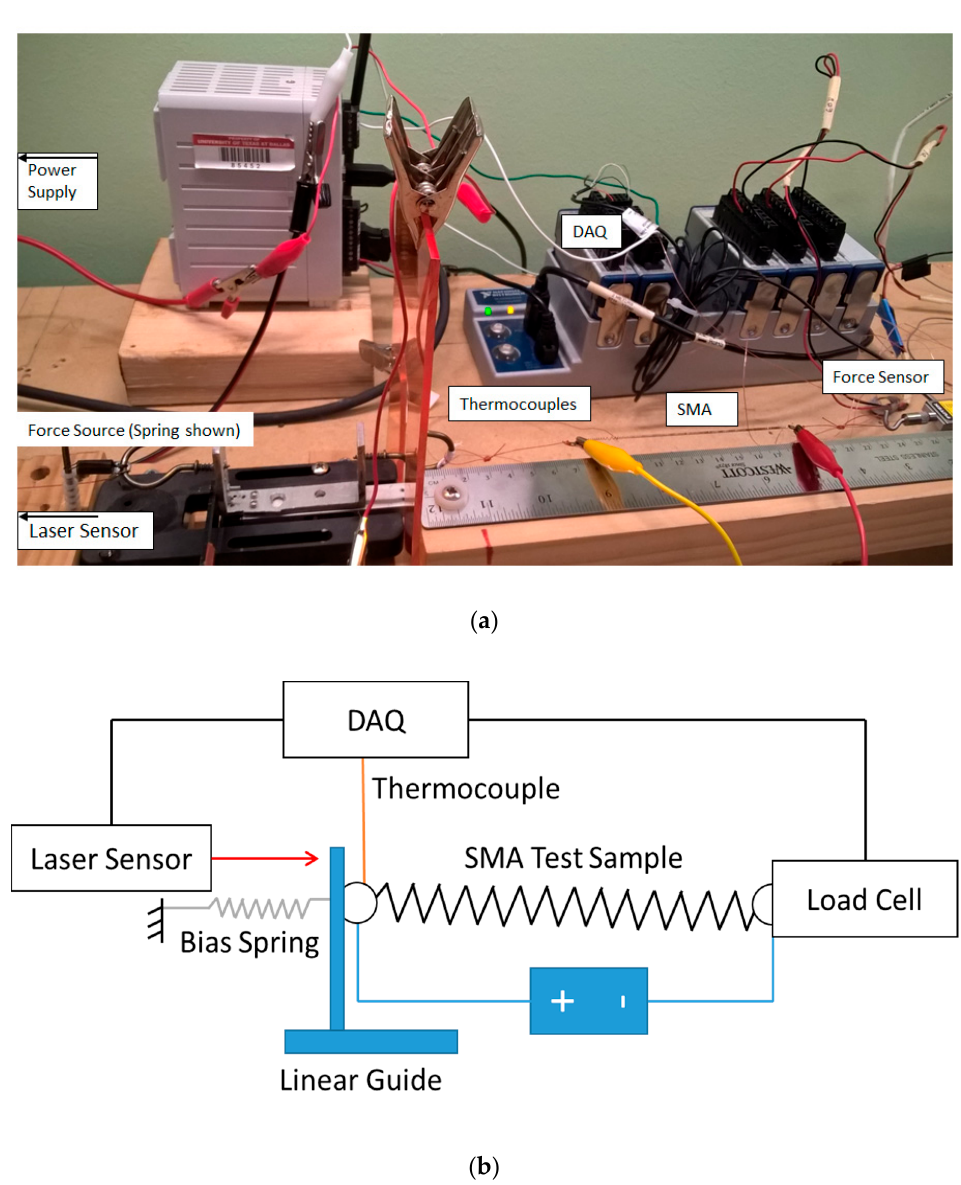
Figure 6. Muscle characterization setup ( a ) image and ( b ) schematic. A coiled shape memory alloy muscle was prepared with the characteristics listed in Table 3. The muscle was pretensioned to 100 mm, with one end attached to a force probe, while the other end was attached to the spring. A square wave of varying magnitudes (0.3, 0.5 and 0.7 A) was applied to the muscle, with a 2 s on and 8 s off cycle for 5 cycles.